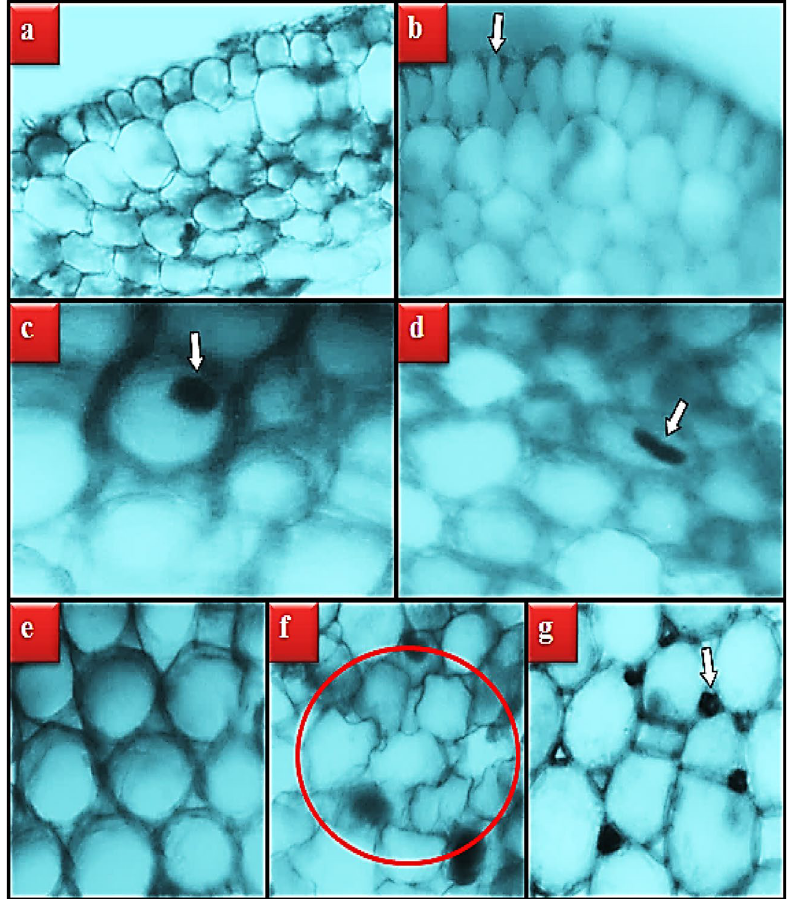
Figure 6. Meristematic cell damages caused by MnCl 2 toxicity. Normal appearance of epidermis cells ( a ), epidermis cell damage ( b ), normal appearance of cell nucleus- oval ( c ), flattened cell nucleus ( d ), normal appearance of cortex cells ( e ), cortex cell damage- red region , cortex cell wall thickening ( g